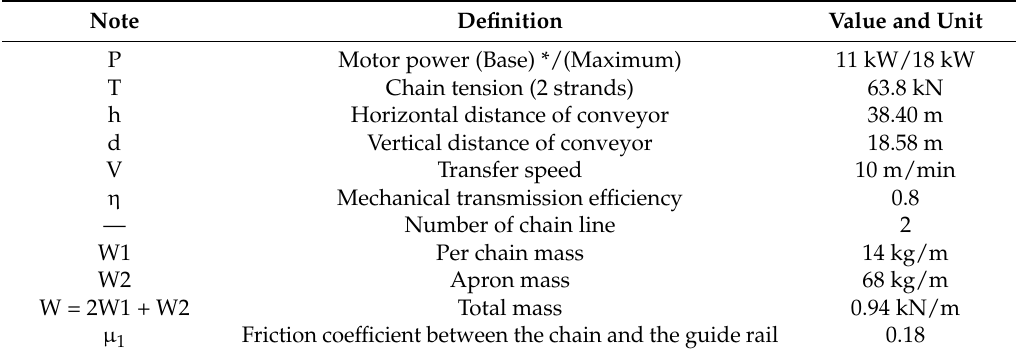
Table 1. Specification of the conveyer chain.